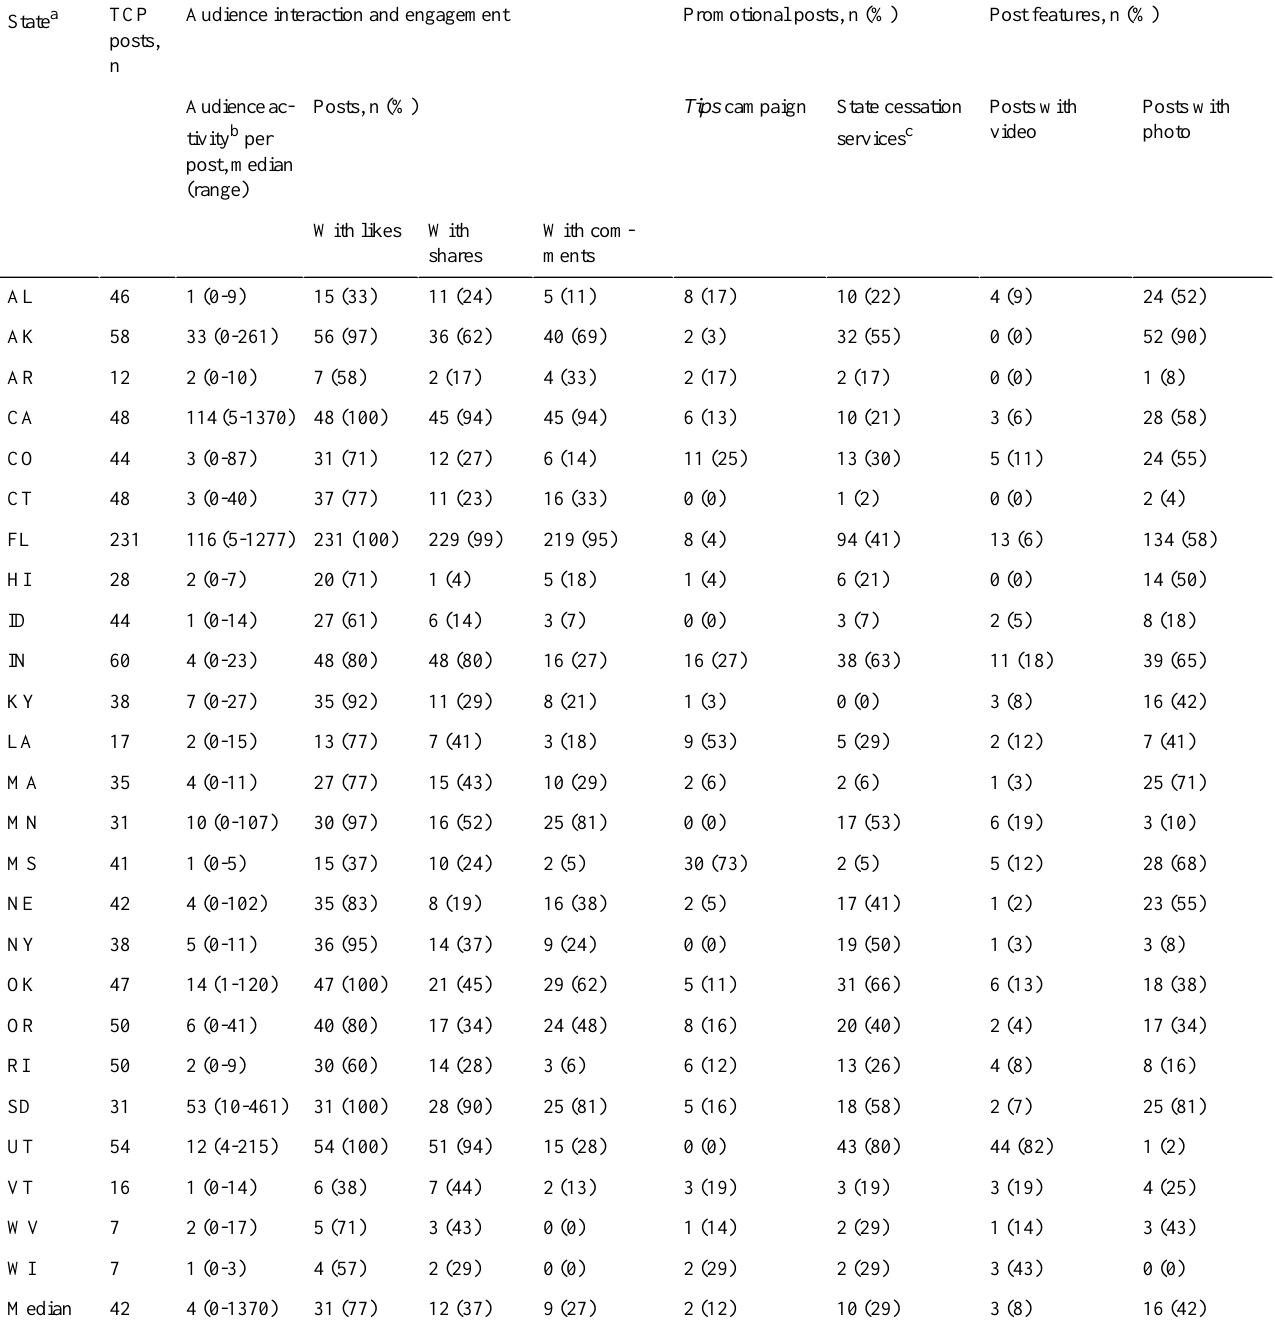
Table 2. Audience engagement with TCP Facebook sites and content of posts, March to June